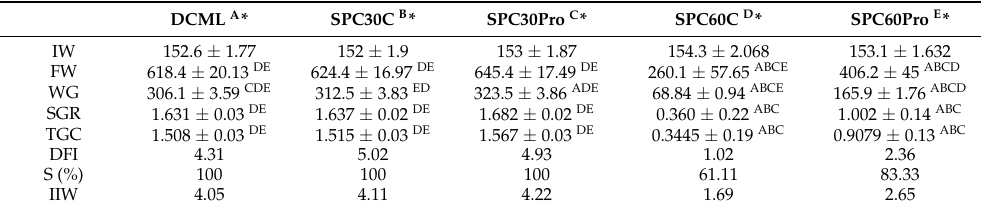
Table 2. Growth performance of Totoaba macdonaldi fed with two levels of SPC and Bacillus subtilis 9b.